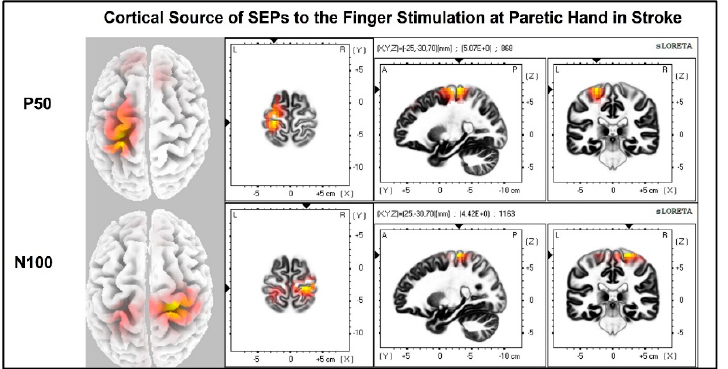
Figure 9. Cortical sources of SEP components in stroke when the paretic hand is stimulated. The paretic (right) hand was stimulated, contralateral (left) source activities were detected at the time point of P50, and bilateral source activities (more activities in the ipsilateral (right) hemisphere) are detected at the time point of N100.